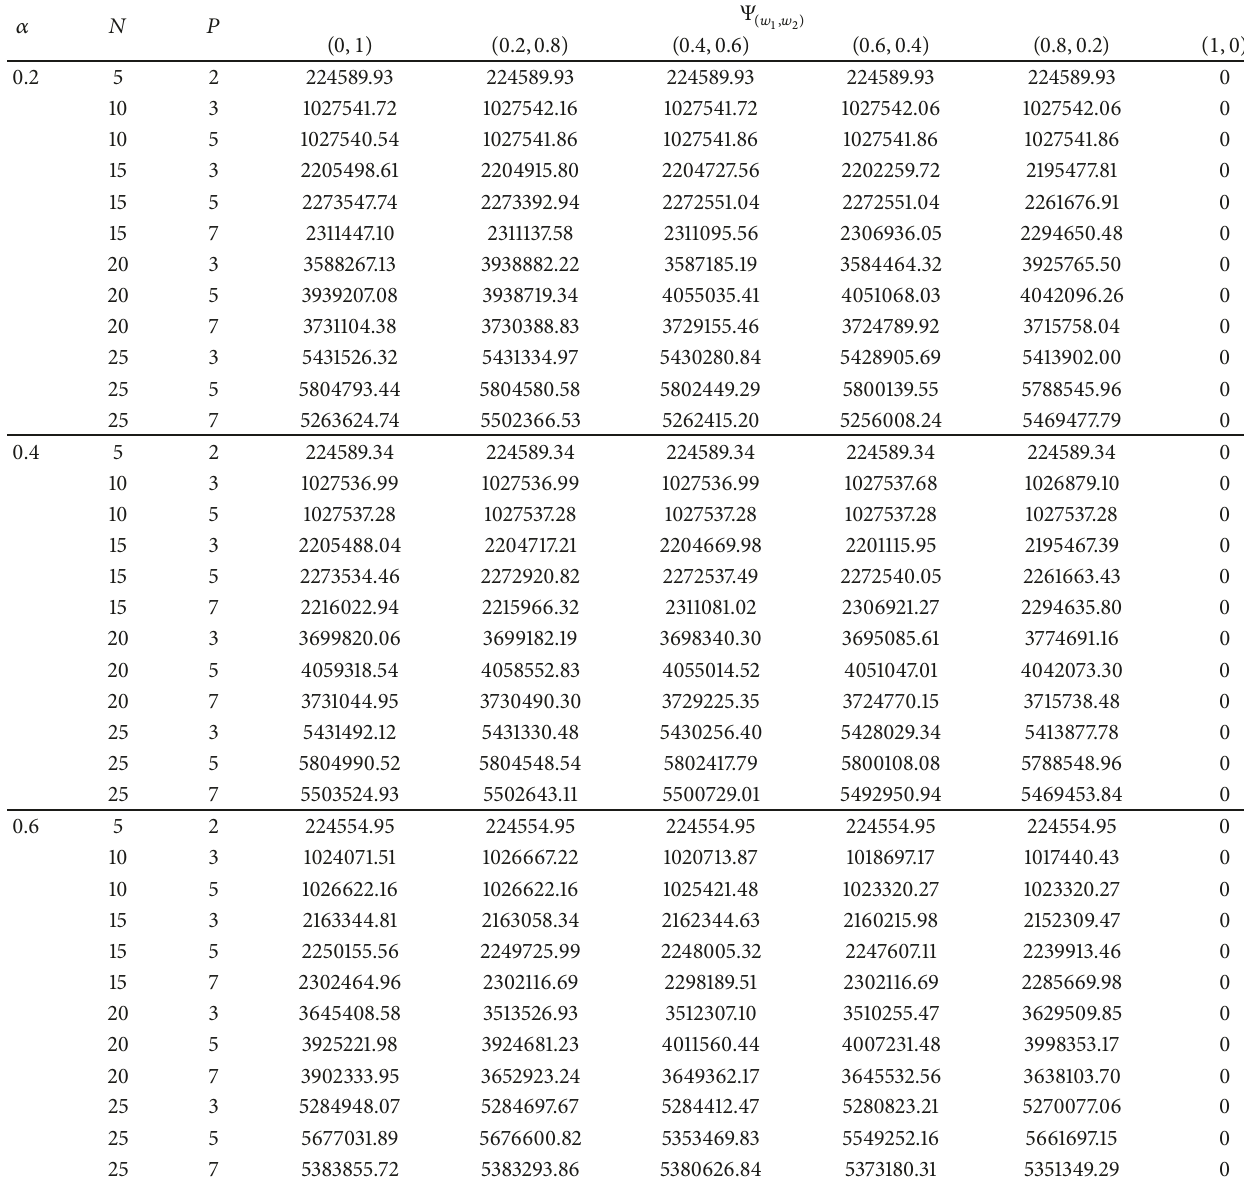
Table 3: Results of Ψ under all weight